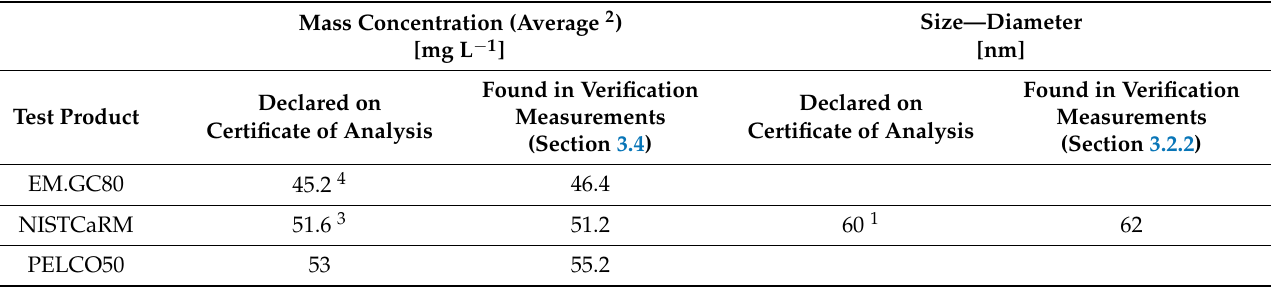
Table 7. Mass concentrations and particle sizes declared on certificate of analysis opposed to those determined in this study.